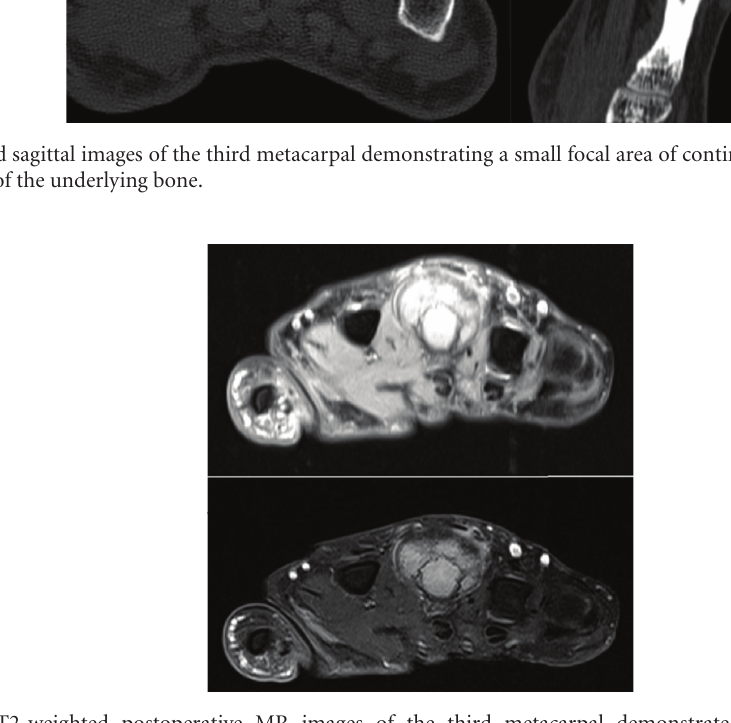
Figure 6: Axial T1/T2-weighted postoperative MR images of the third metacarpal demonstrate a somewhat mushroom-shaped, pedunculated lesion arising from the dorsal aspect of the third metacarpal with an internal signal similar to that of the underlying